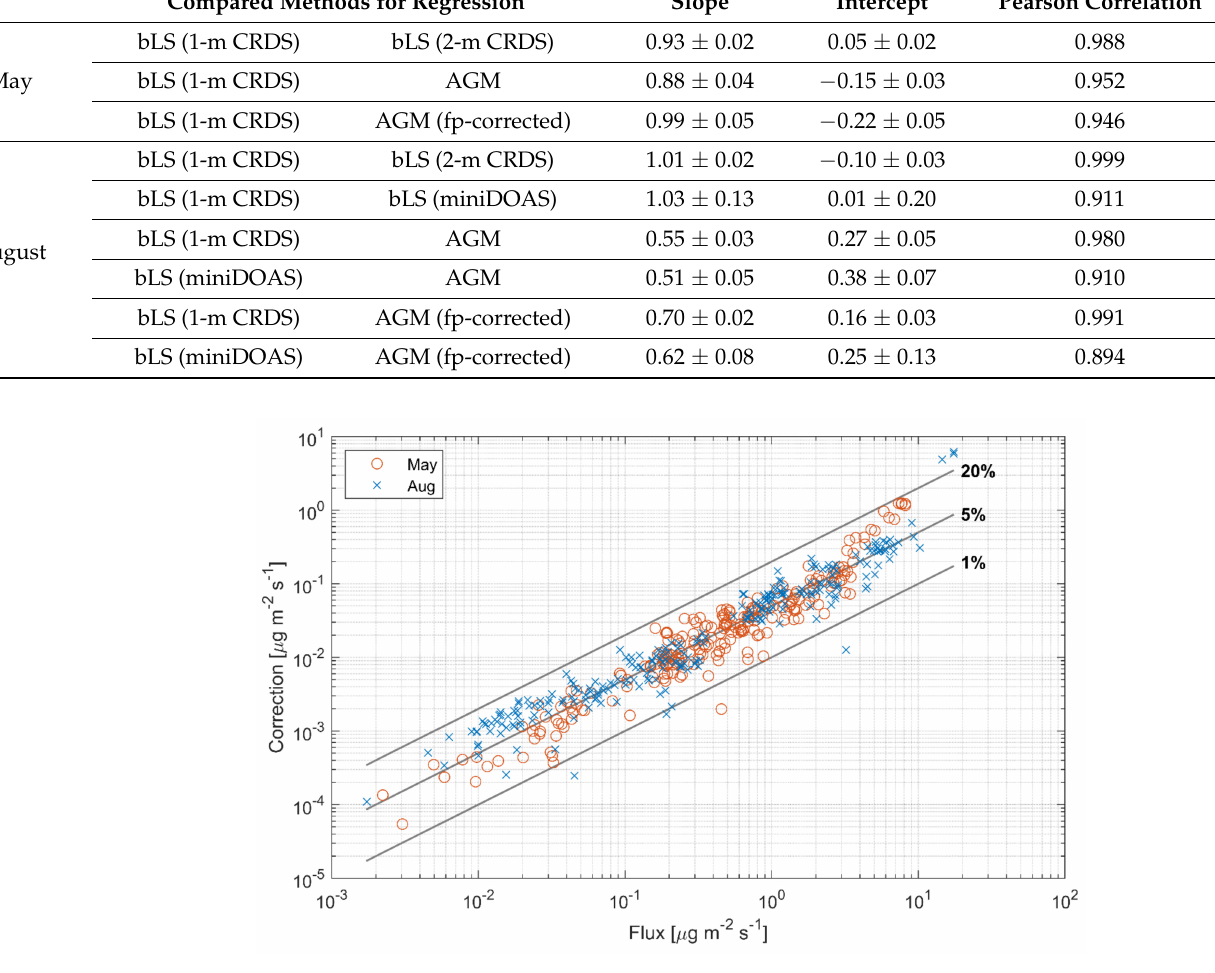
Figure 8. Correction of the AGM emissions depending on the emission magnitude. The black lines indicate correction levels of 1%, 5%, and